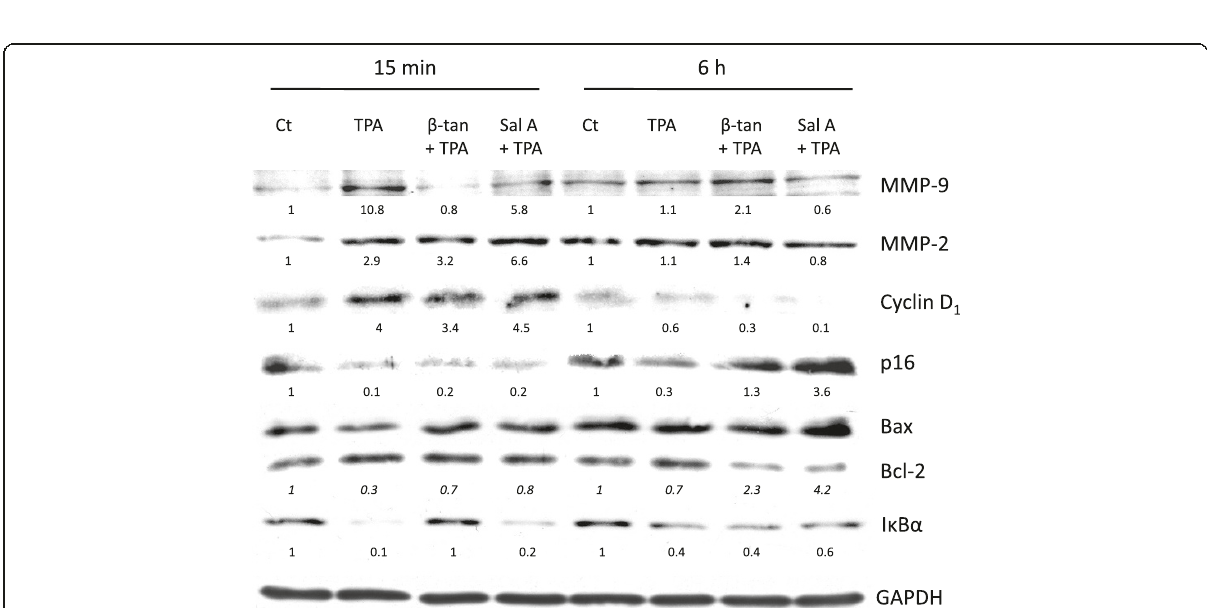
Figure 4 β -tan and Sal A decrease basal and TPA-induced NF- κ B transcriptional activities. At 60 – 80% confluency, JB6P+cells were transiently co-transfected with control renilla luciferase reporter construct and AP-1 or NF- κ B firefly luciferase reporter constructs and were pre-treated with the indicated concentrations of β -tan (A) or Sal A (B) for 1 h followed by TPA treatment up to 24 h. Results were standardized relative to renilla luciferase and expressed as percentage of control (Ct)-treated cells. Significance from Ct-treated condition is indicated as ** at p < 0.01 and *** at p < 0.001. Significance from TPA-control condition is indicated as †† at p < 0.01 and ††† at p < 0.001. Results are representative of two independent experiments and plotted as averages of triplicate wells (± SD).